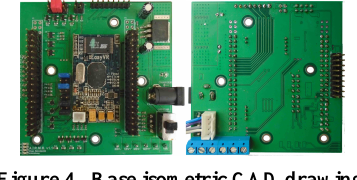
Figure 4. Base isometric CAD drawing. Table 1. Beaglebone vs. Raspberry Pi